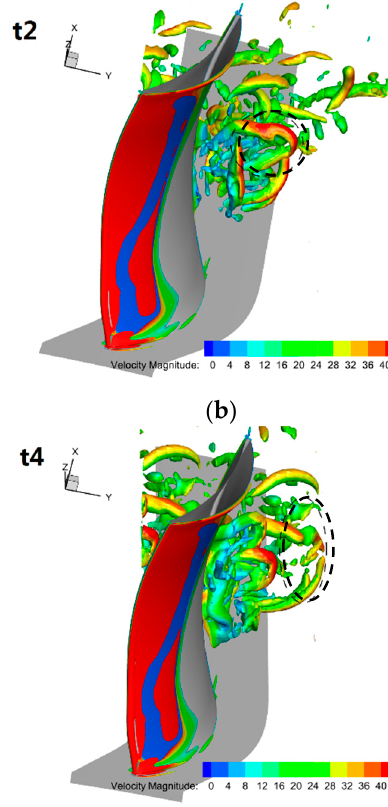
( b ) Figure 13. Velocity distribution of monitor points: ( a ) P1; ( b ) P2. Three directions’ velocity data are analyzed by PDF method. Figure 14a–c show that the streamwise velocity PDF of P1 ranges from 34 m/s to 41 m/s, the pitchwise velocity PDF of P1 ranges from 7 m/s to 14 m/s, and the radial velocity PDF of P1 ranges from − 4 m/s to − 0.5 m/s, so the streamwise velocity plays a major role in three direction velocities. For the monitor point in the corner separation region (P2), the three-direction velocity PDF is basically close, ranging from − 15 m/s to 10 m/s, as shown in Figure 14d–f. The reason for the uniform distribution of velocity probability density in the three directions is that the interaction of vortices in the corner region makes the turbulent kinetic energy transport more active.